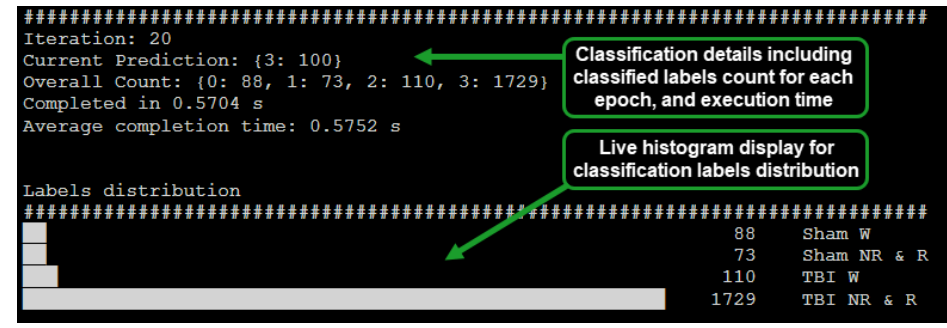
Figure 3. Live classification display for the RPi based system (64 s epoch, batch size: 100).